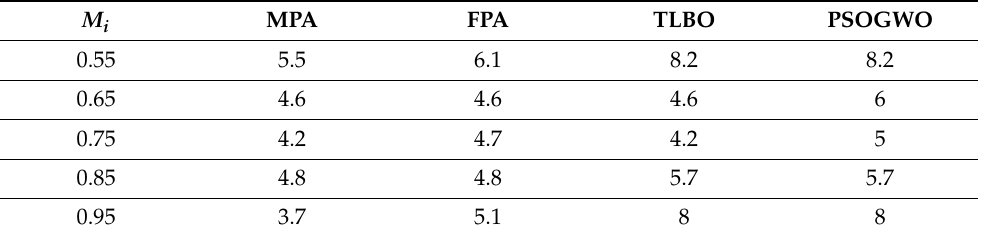
Table 1. Total harmonic distortion (THD) (%) for different algorithms at different modulation indexes.